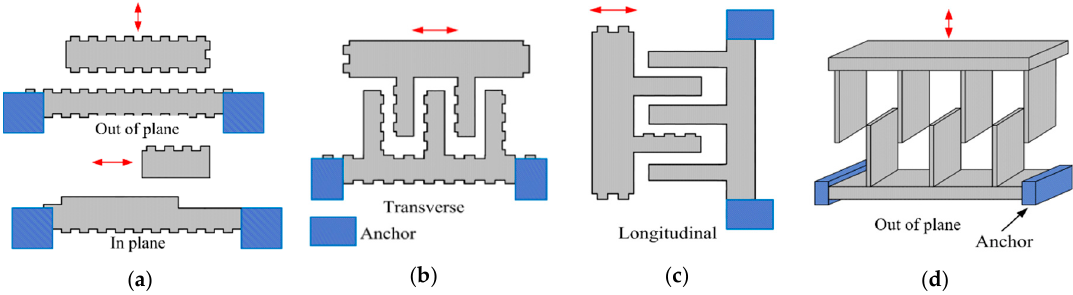
Figure 3. Various configurations of electrostatic actuation: ( a ) Parallel-plate structure (out-of-plane motion and in-plane motion); ( b ) transverse motion comb structure; ( c ) longitudinal motion comb structure; ( d ) out-of-plane motion comb structure.